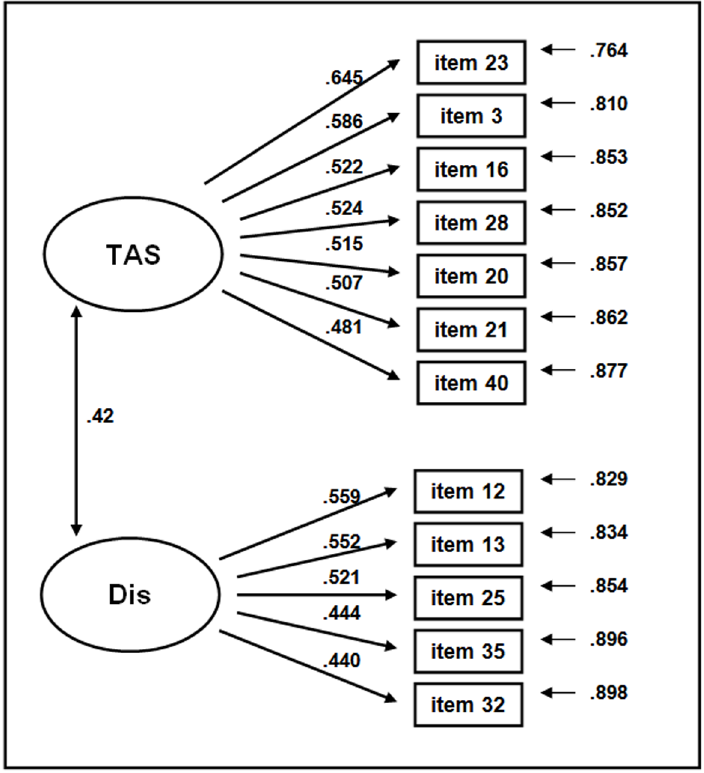
Figure 1. Confirmatory factor analysis: Empirical model (standardized solution).